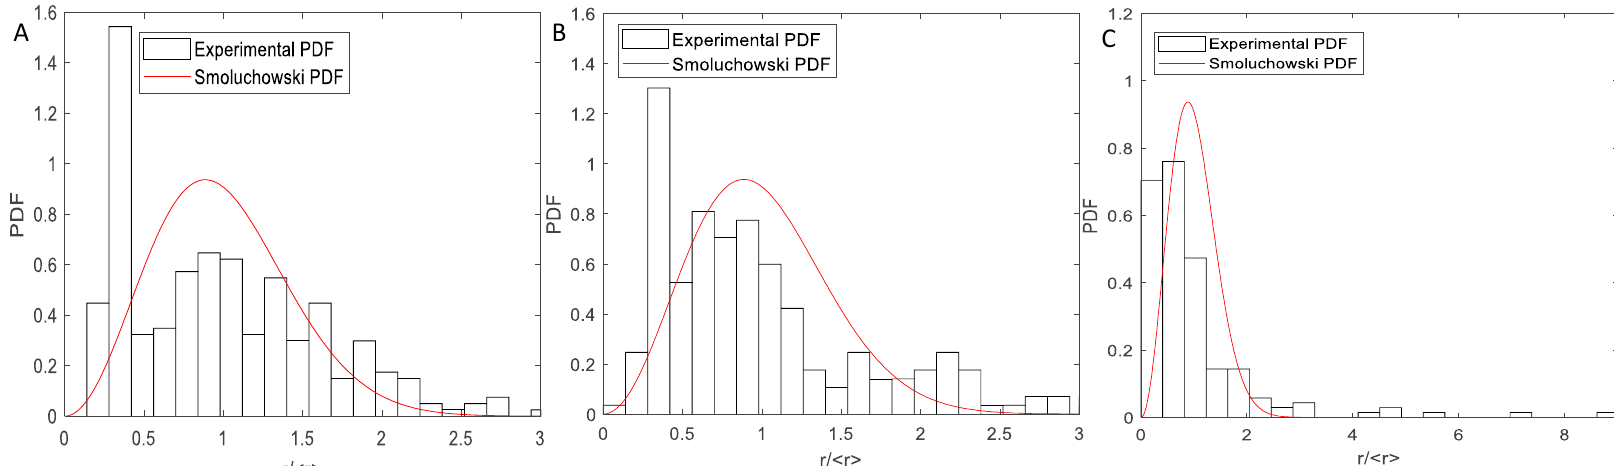
Figure 4. Cluster size distribution of aggregates formed at di ff erent precipitant concentrations. ( A – C ) represents aggregation induced by adding 52 vol%, 55 vol%, and 57 vol% heptane into model oil, respectively. Cluster size distributions for each experiment are normalized by their respective mean values to facilitate direct comparison. The red lines are the particle size distribution for Smoluchowski kinetics.